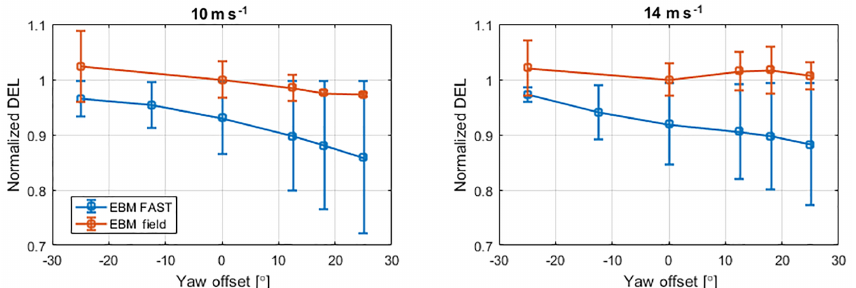
Figure A2. Comparison between predicted (FAST) and measured (field) EBM DELs.